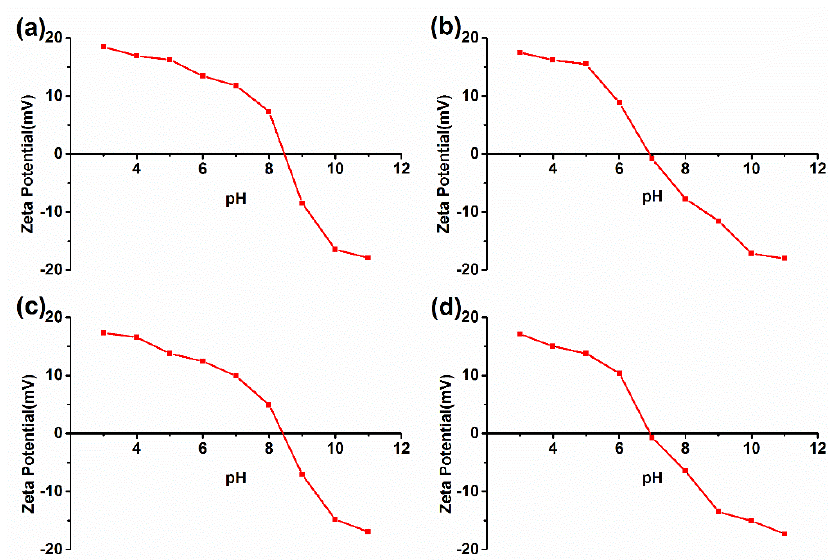
Figure 2. Zeta potential of 1.0 mg mL − 1 solutions of 4-arm star-PAA 1 - b -PDMAEMA 4 ( a ), star-PAA 2 - b -PDMAEMA 4 ( b ), star-PDMAEMA 4 - b -PAA 1 ( c ), and star-PDMAEMA 4 - b -PAA 2 ( d ) at different pH values.